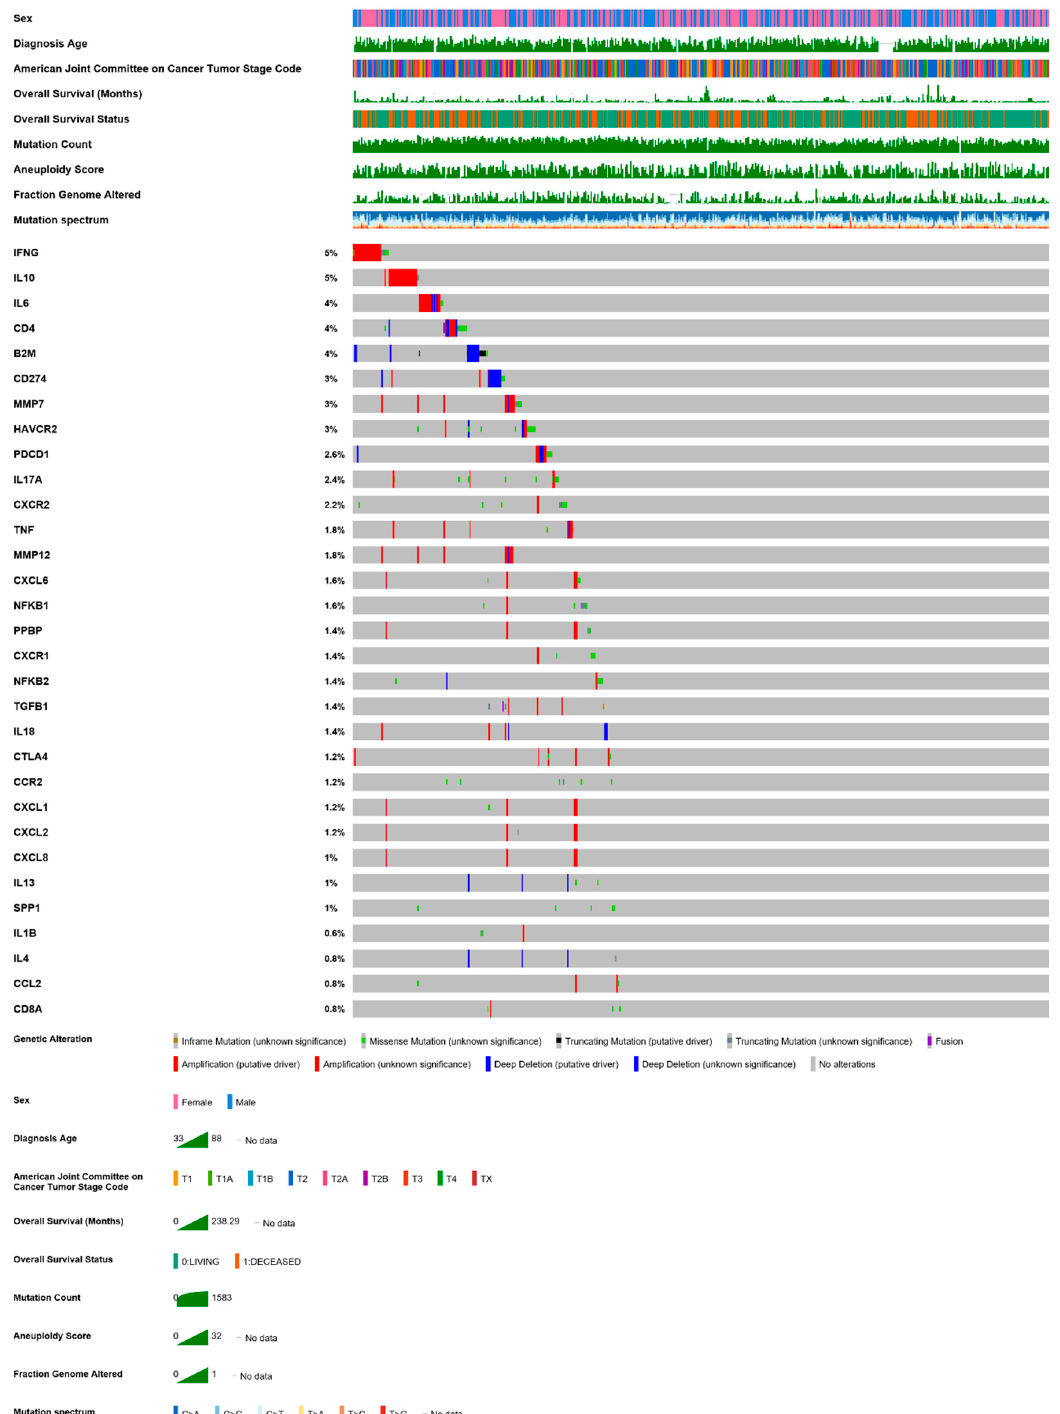
Figure 2. A mutation plot of altered immune genes reviewed in this text in the TCGA pan-cancer LUAD dataset ( n = 507). Queried genes ( IFNG , IL10 , IL6 , CD4 , B2M , CD274 , MMP7 , HAVCR2 , PDCD1 , IL17A , CXCR2 , TNF , MMP12 , CXCL6 , NFKB1 , PPBP , CXCR1 , NFKB2 , TGFB1 , IL18 , CTLA4 , CCR2 , CXCL1 , CXCL2 , CXCL8 , IL13 , SPP1 , IL1B , IL4 , CCL2 , CD8A ) were altered in 135 patients (98%). Data from https://www.cbioportal.org/study/summary?id=luad_tcga_pan_can_atlas_2018